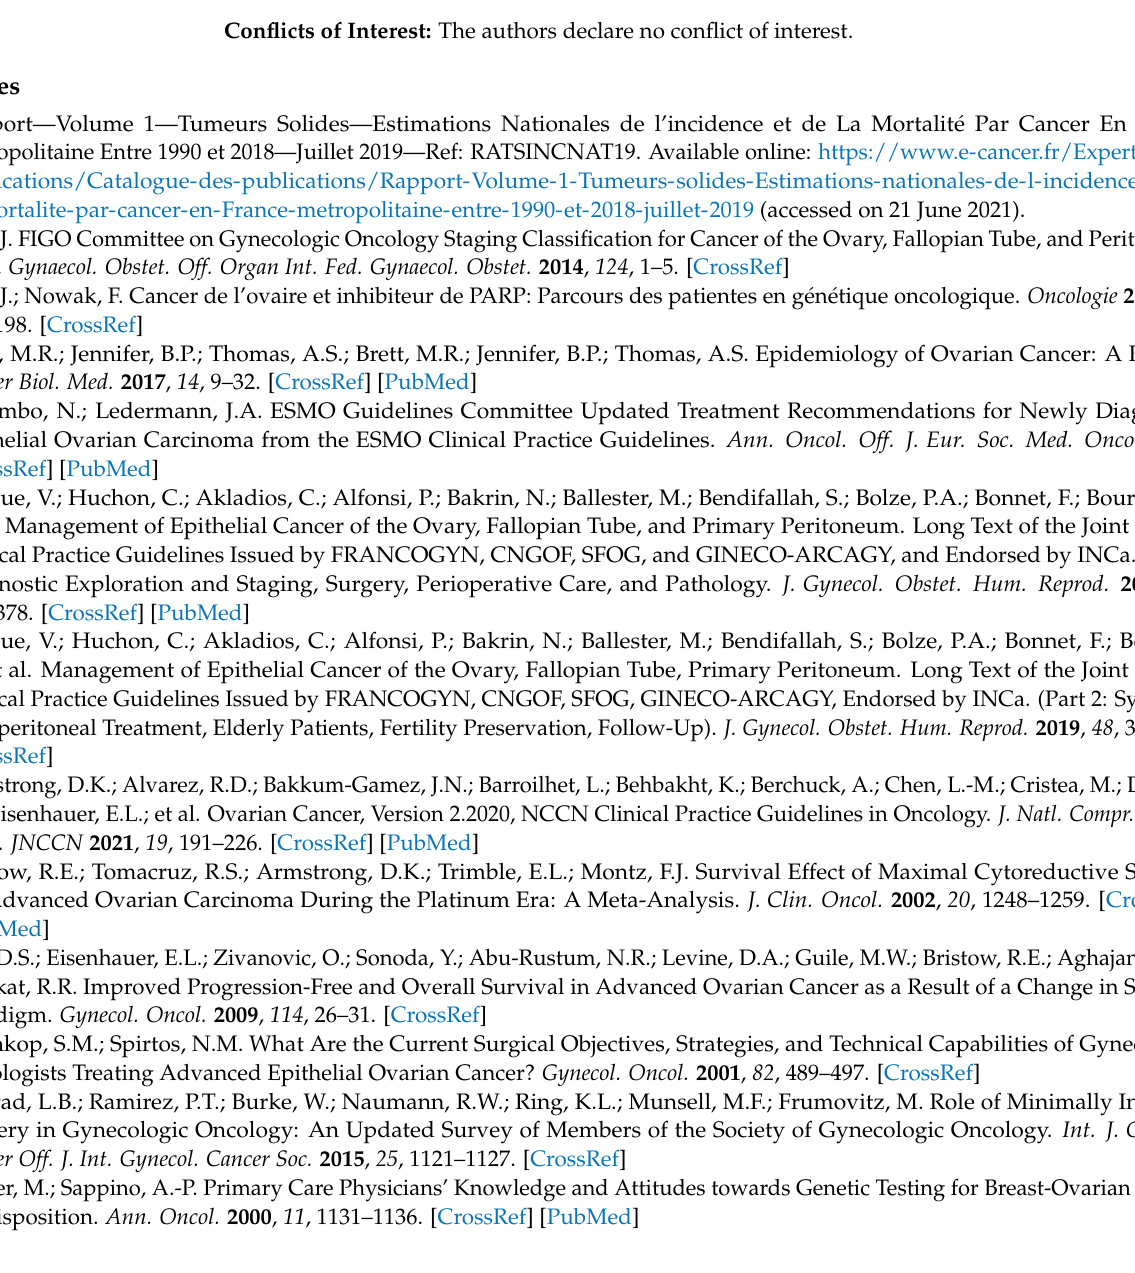
Supplementary Table S1. Percentage of responses and specialties of participants for each